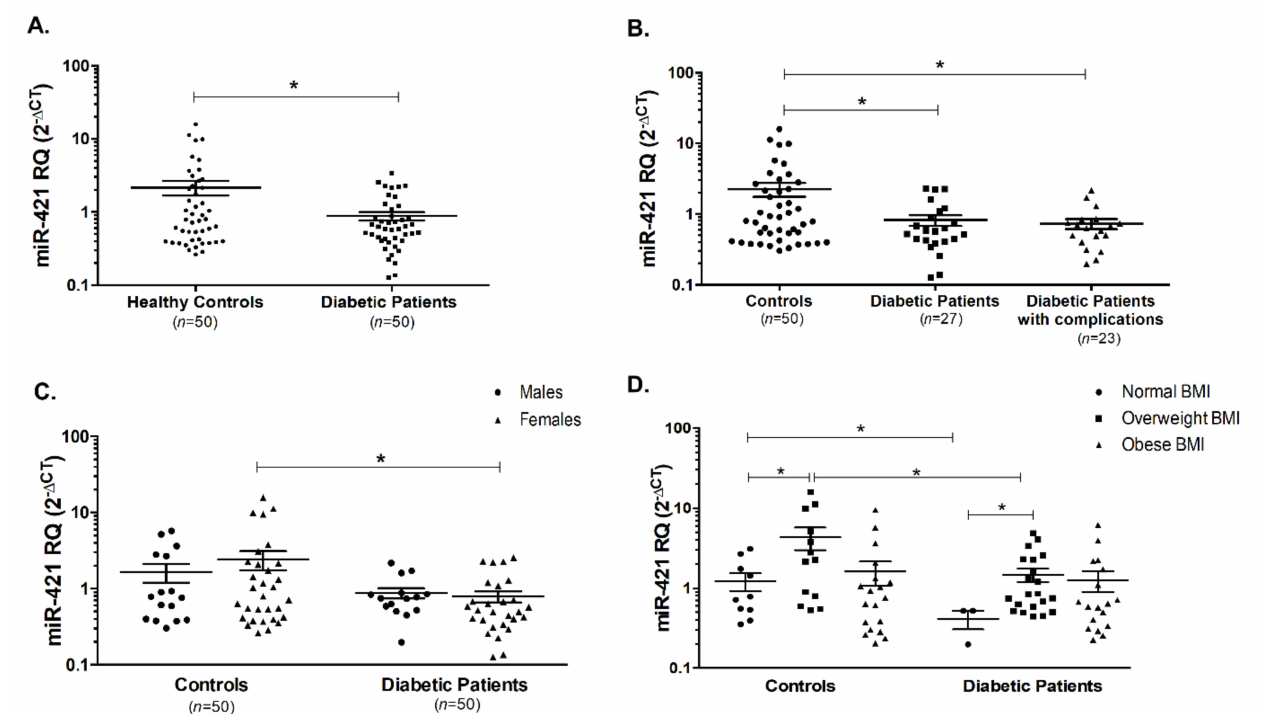
Figure 2. Serum levels of miR-421 in diabetic patients and healthy controls. ( A ) miR-421 was significantly reduced in diabetic patients compared to healthy controls. ( B ) Declines in miR-421 levels were significant in diabetic patients with the presence and absence of complications. ( C ) miR-421 was significantly reduced in female diabetic patients compared to female healthy controls. ( D ) miR-421 levels were significantly altered in the different categories of healthy controls and diabetic patients depending on BMI. * indicates p <